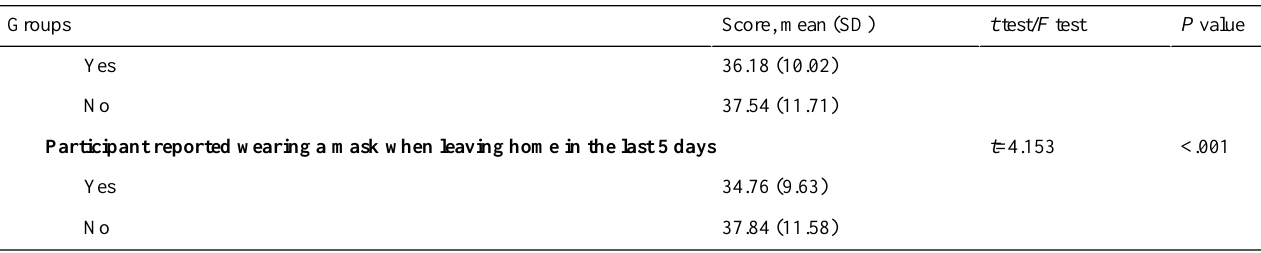
Wore mask, OR CI)Gathering of more (95% than 50 people,